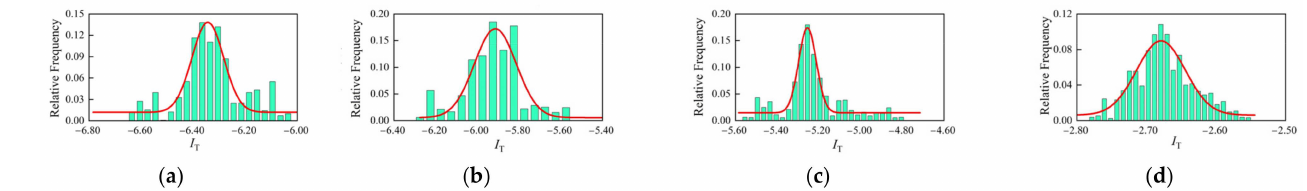
Figure 11. Posteriori relative frequency distribution of member 1. ( a ) Healthy; ( b ) mild injury; ( c ) moderate damage; ( d ) severe injury.